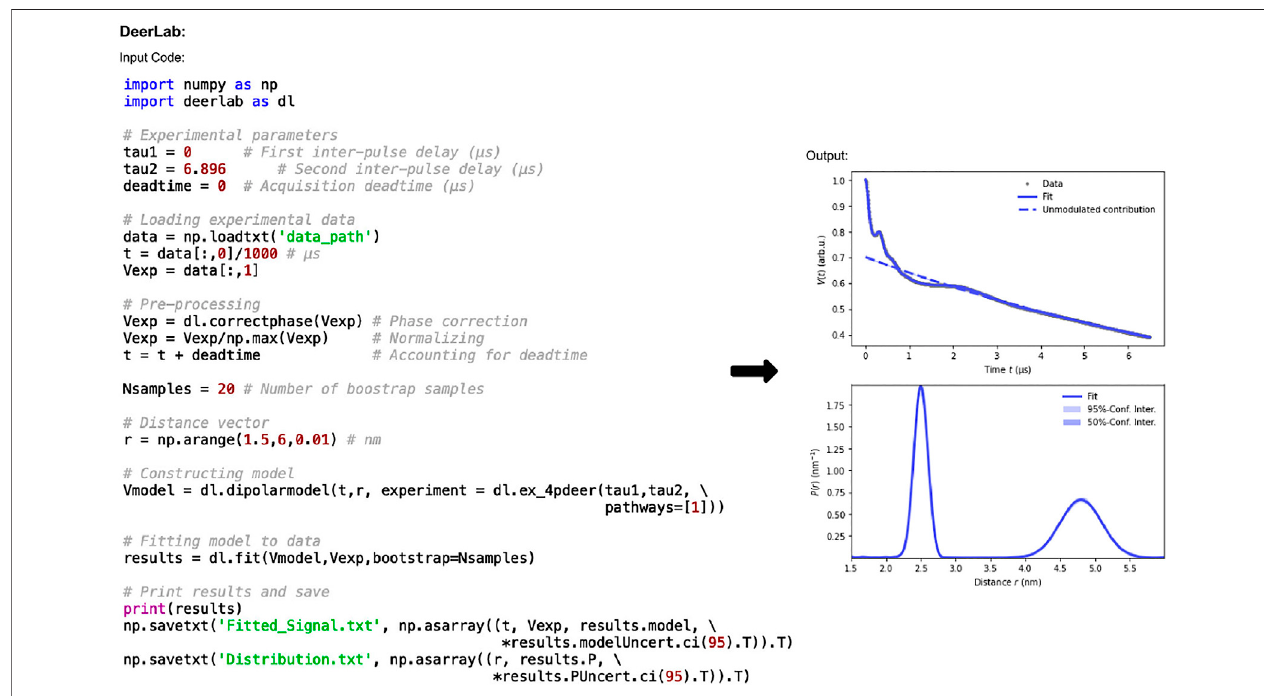
FIGURE 2 | DeerLab pre-release v0.14.0 work fl ow. The package is Python-based and available on all operating systems. Data set shown is simulated noiseless, whichwasanASCII fi le.ForusersusingElexsys fi letypes,thelinesofcode “ data_path= ‘ / ... /data/data fi le.DTA ’” and “ t,Vexp=dl.deerload(data_path) ” shouldbeused in place of “ data = np.loadtxt ( ‘ data_path ’ ) ” and the two following lines in panel one.